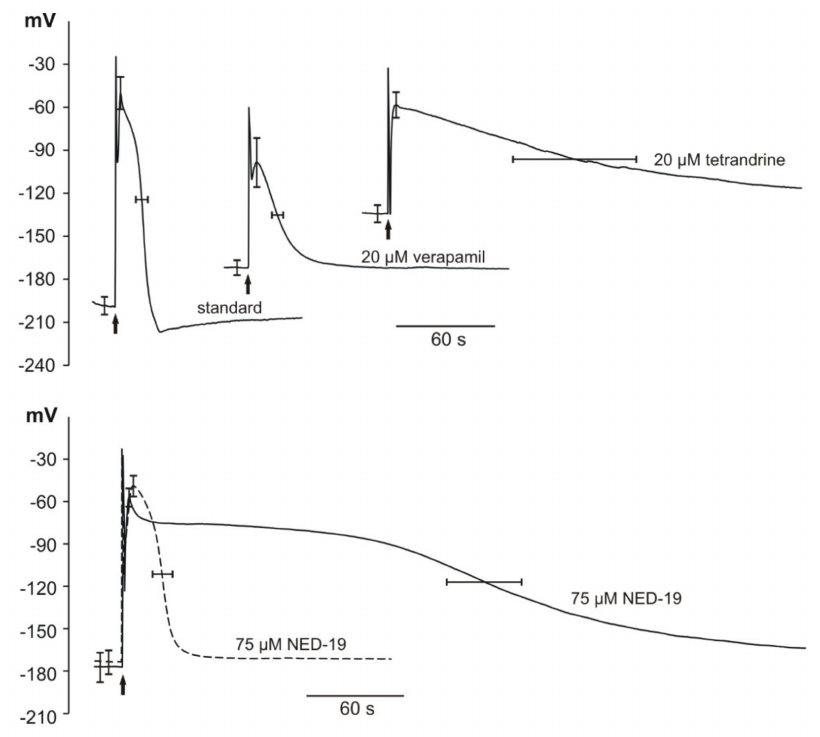
Figure 4. Influence of different inhibitors of human TPCs on electrically evoked action potentials in Marchantia polymorpha . Representative intracellular recordings observed in the standard solution and the standard solution supplemented with different inhibitors. Arrows indicate the moment of stimulation (4 V for 1 s). Stimulation evoked an artifact which is visible at the beginning of each recording. Two kinds of responses evoked by NED-19-short (dashed lines) and long lasting (solid lines) are presented at the bottom of the figure. The values of membrane potential are presented on vertical axes.